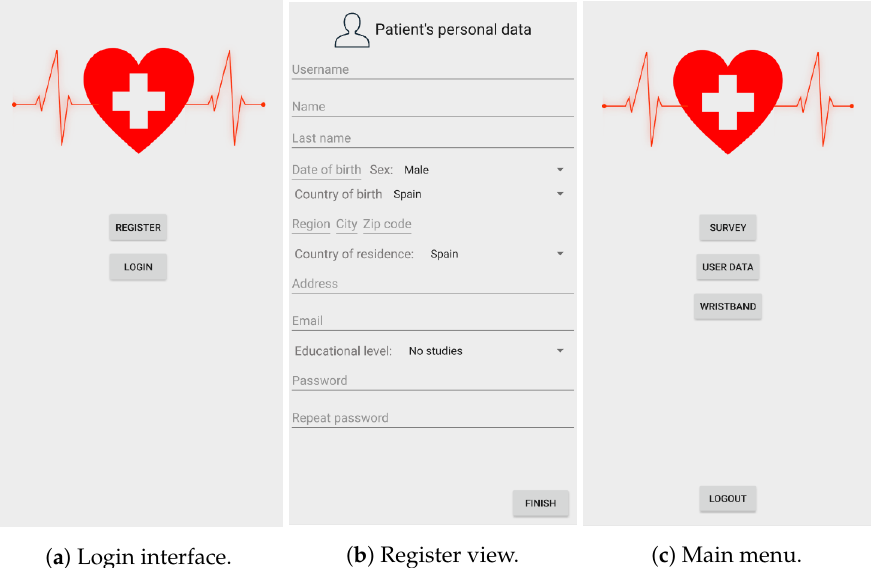
Figure 5. Views representing the access to the application, including register and login